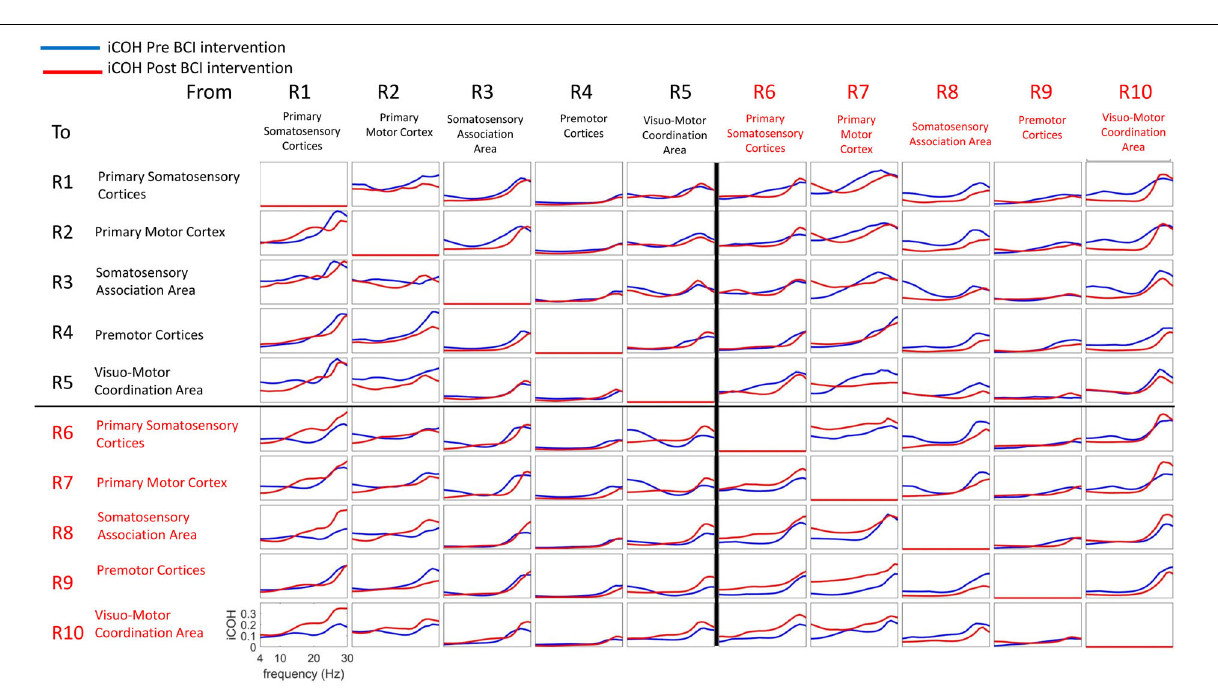
FIGURE 6 | Isolated effective coherence (iCoh) – Frequency Specific Directional Flow of Information Transmission (Left Hand, Impaired Movement). Isolated effective coherence (iCoh), Pre (blue) and Post (red) BCI intervention. Vertical axis: 0 to 1. Horizontal axis: spectral frequency, 4–30 Hz. Columns are the senders, rows are receivers (i.e., FROM the top row of ROIs TO the horizontal columns of